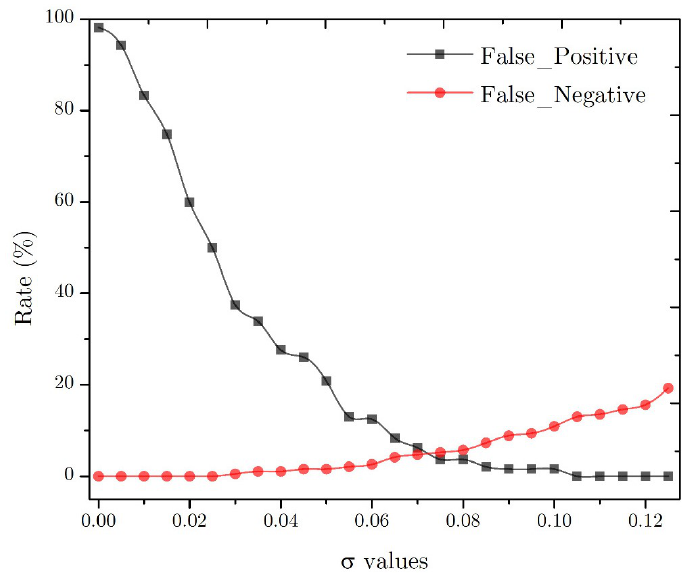
Figure 9. Variation of false negative rate and false positive rate for different values of σ